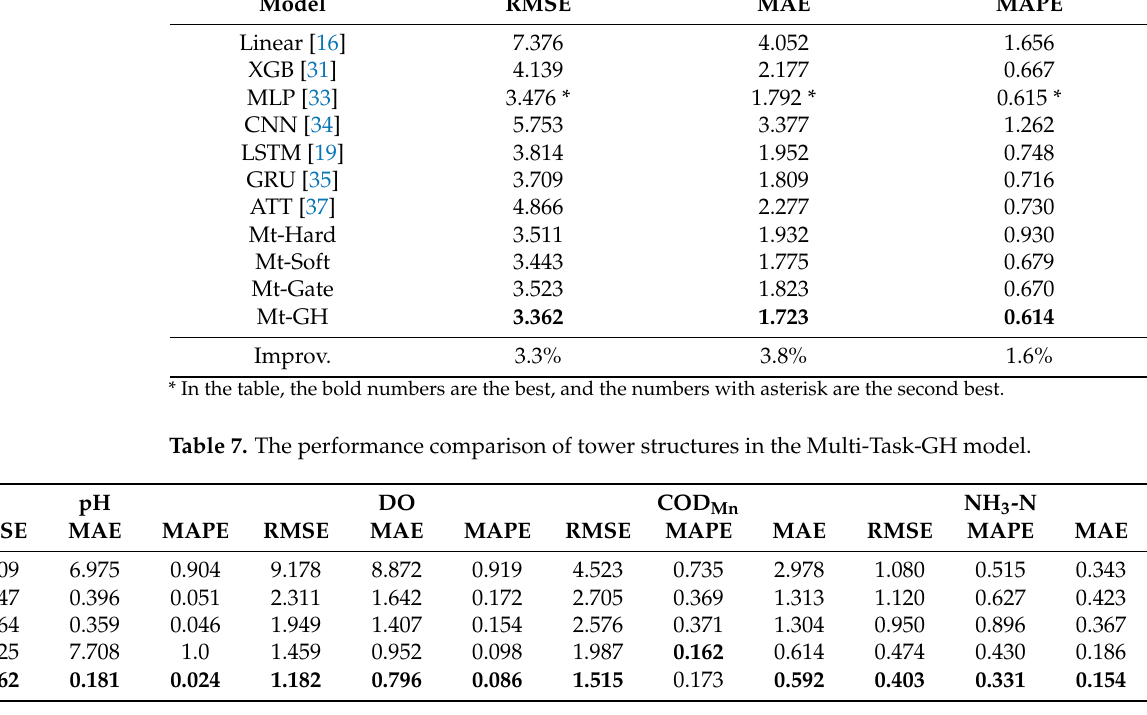
Table 6. Comparison of the overall performance of prediction for multi-indicator. Model RMSE